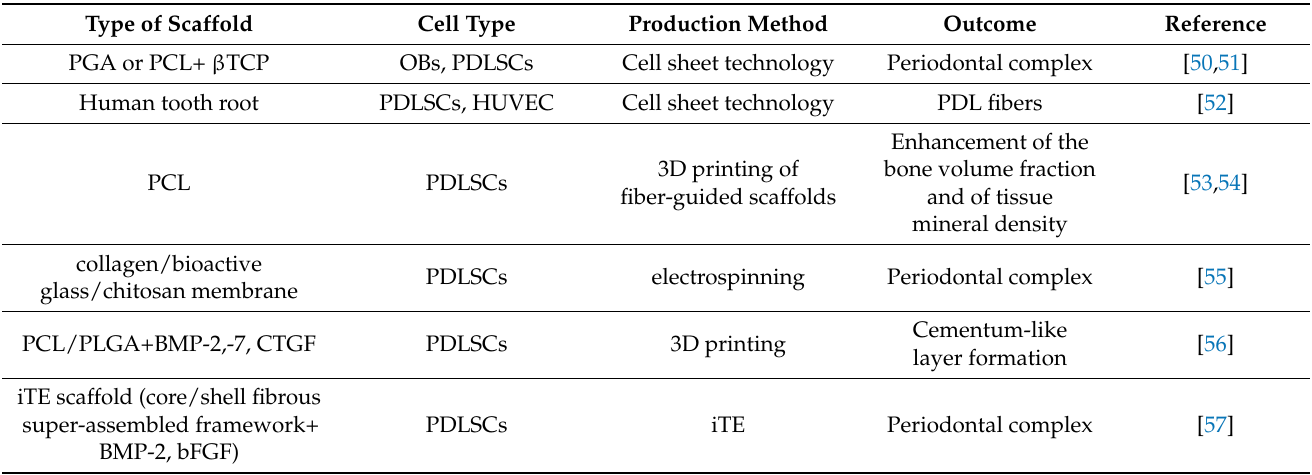
Table 2. Representative in vivo studies using different scaffolds and PDLSCs to regenerate the periodontal